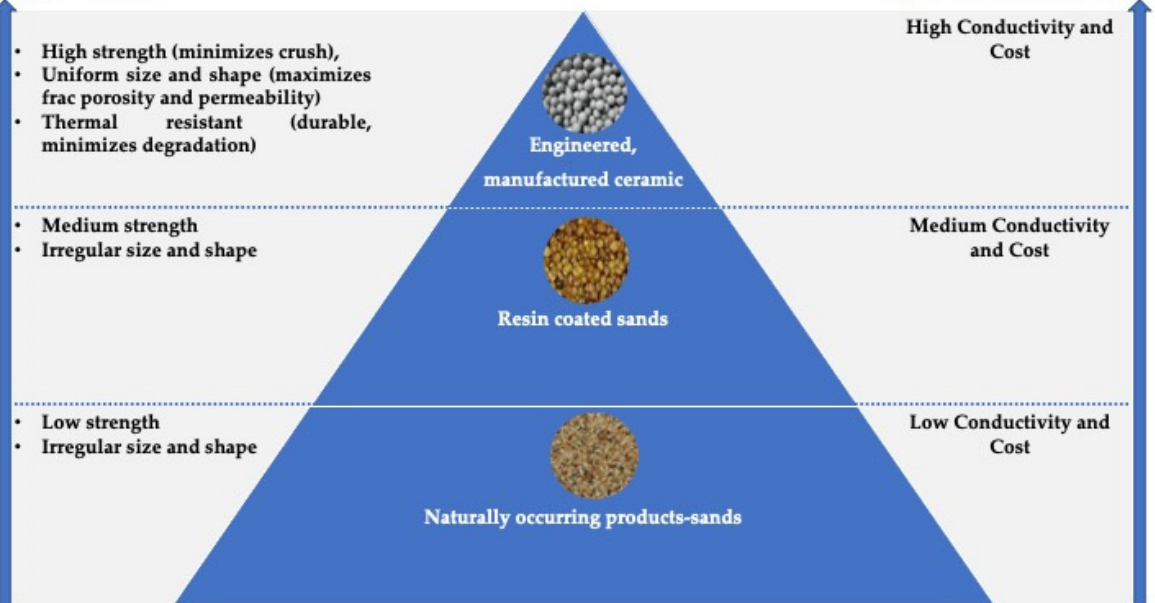
Figure 20. Proppants and their features (modified from [212]).